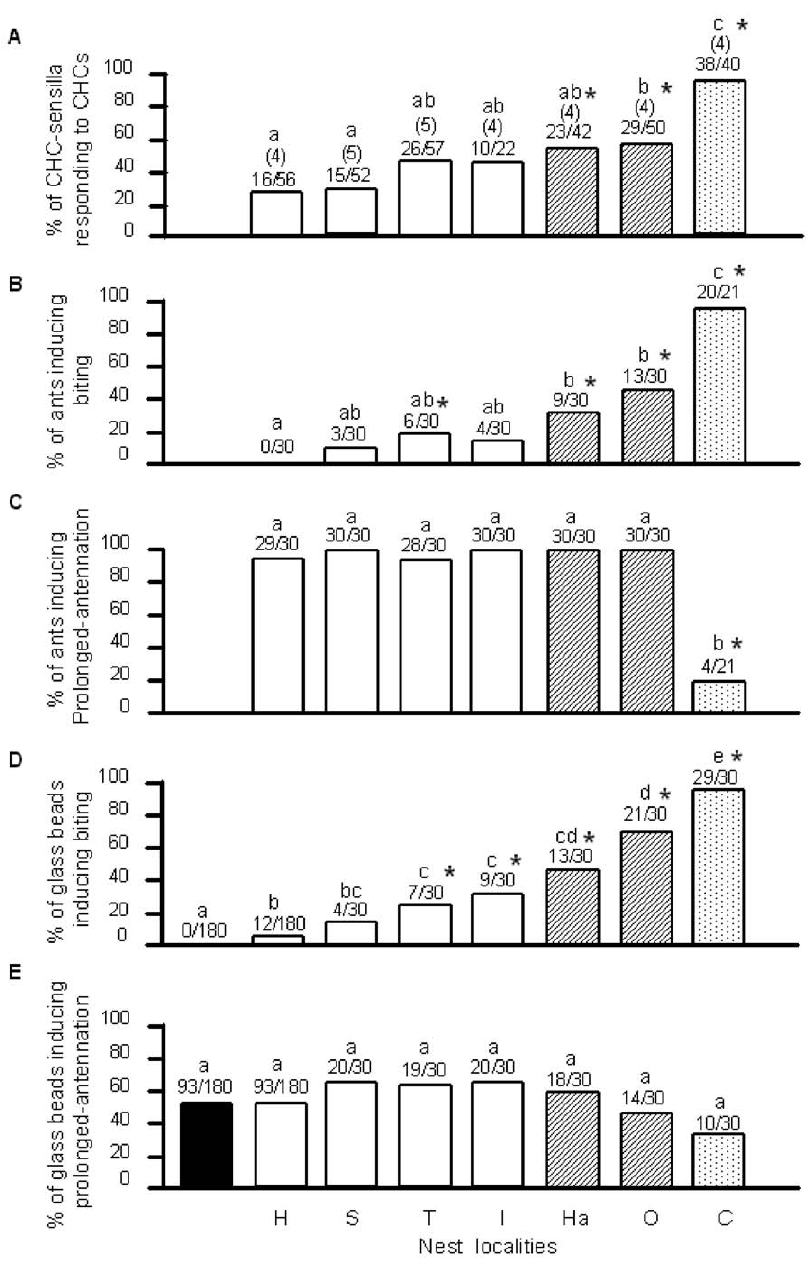
Figure 5. Ratios of activated sensilla and behavioral responses of ‘‘Hoshioki’’ workers to live or surrogate ants. ( A ) Percentage of CHC sensilla in ‘‘Hoshioki’’ workers showing an electrophysiological response to CHCs of workers of F. yessensis from nests within (white columns) and outside (hatched columns) the ‘‘Ishikari supercolony’’, and C. japonicus CHCs (dotted columns). The fractions indicate the number of sensilla responding to the stimulus CHCs per total number of sensilla tested. The numbers in parentheses indicate the number of ants used. ( B ) Percentage of workers from the above nests (out of the total workers tested, respectively) that induced biting behavior of ‘‘Hoshioki’’ workers. ( C ) Percentage of workers from the above nests (out of the total workers tested, respectively) that induced prolonged-antennation behavior of ‘‘Hoshioki’’ workers. ( D ) and ( E ) are same as (B) and (C) but using surrogate invader ants made of glass beads coated with purified CHC. Black columns describe the response to n -hexane control. Different letters indicate significant differences by Tukey WSD test, respectively in plates A–E. Asterisks indicate significant differences from the control levels responding to ‘‘Hoshioki’’ workers or their CHCs by one-sided Fisher’s exact test with Bonferroni-Holm correction. doi:10.1371/journal.pone.0046840.g005 supercolony. However, even within the supercolony there was members of the supercolony can again be explained by their a statistical correlation between CHC profile disparity and limited migration range from each resident nest [26]. Thus, the geographic distance (Figures 2D, 2E and S1B), although the slope between-nest worker exchange and therefore odor homogeniza- for nests within the supercolony was gentler than that between tion were limited [29,30], but at the same time, odor similarity supercolonies. The slight disparity in CHC profiles among within the supercolony could be maintained as a whole, resulting